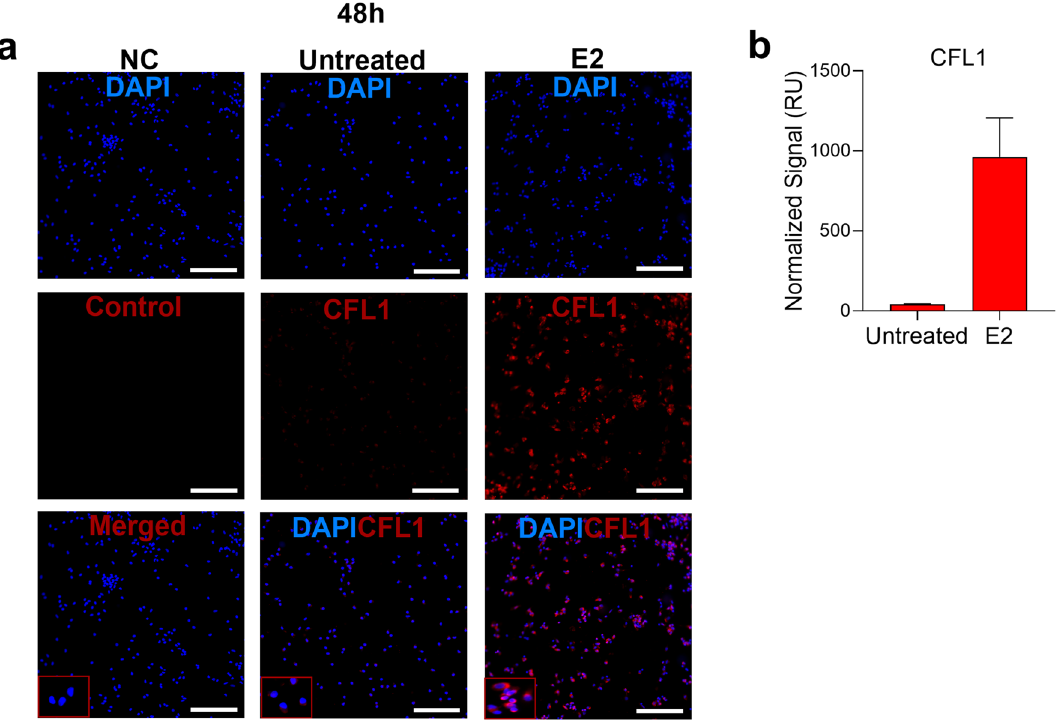
Figure 2. E2 induces CFL1 expression in uninfected PBMCs. (a) PBMCs were incubated with E2 10,000 pg/ ml (vs. untreated control) for 48 h and then transferred to poly l-lysine coated slides for 1 h. PBMCs were then fixed, permeabilized and stained with rabbit anti-human CFL1 Ab followed by goat anti-rabbit AF568 Ab and DAPI. Rabbit IgG and goat anti-rabbit AF568 Ab were used as negative controls (NC) for CFL1 staining in untreated PBMCs. Single experiment representative of 3 experiments is shown (original magnification 20X; scale bar is 100 μm). (b) Shown is the normalized fluorescence intensity of CFL1 staining in relative units (RU) (Mean ± SEM; 3